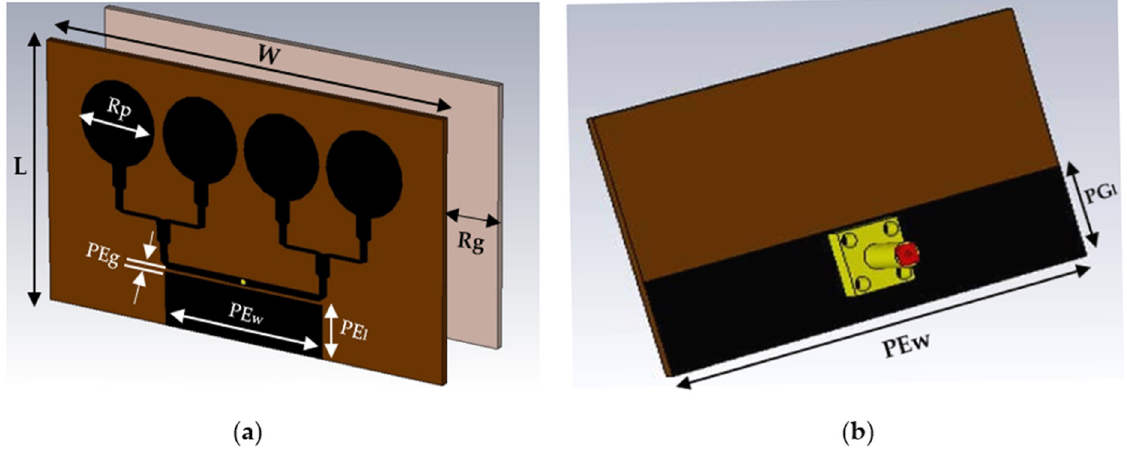
Figure 1. Simulated graphical propose sensor, ( a ) front and ( b ) back (transparent without reflector). Table 2. Geometrical Dimensions.